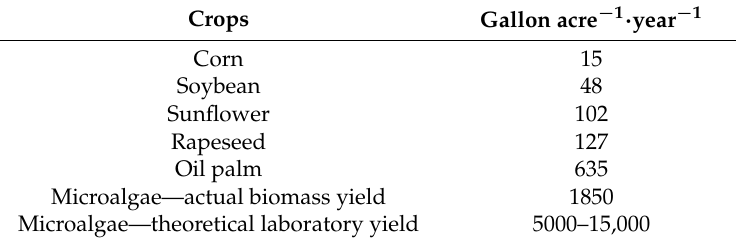
Table 1. Yields of biofuel from different crops. Used with permission from